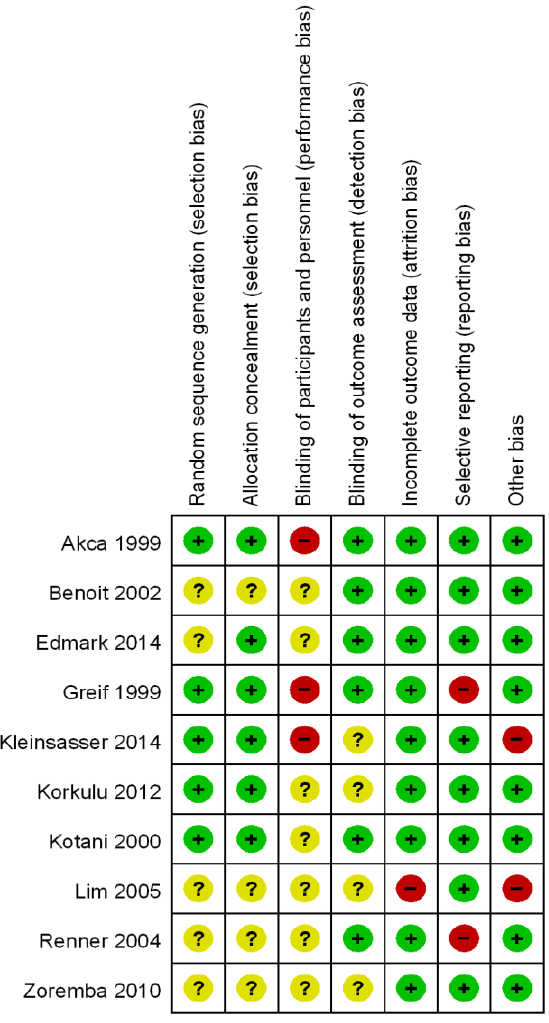
Figure 2. Risk of bias. Review author’s judgement about each risk of bias item for each included study.